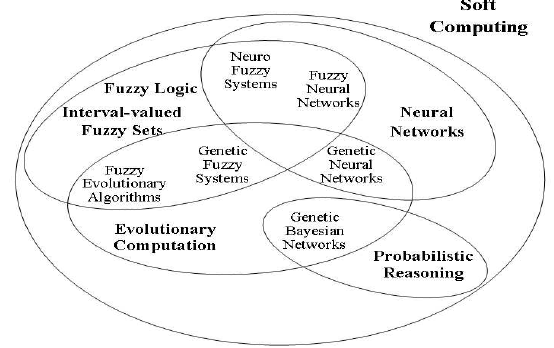
Fig. 1. A graphical view of Hybridization (see 2 )